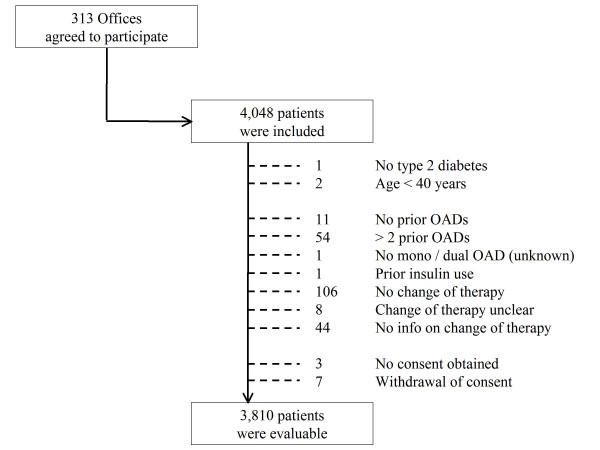
Patient flow chart. OAD, oral antidiabetic drugs